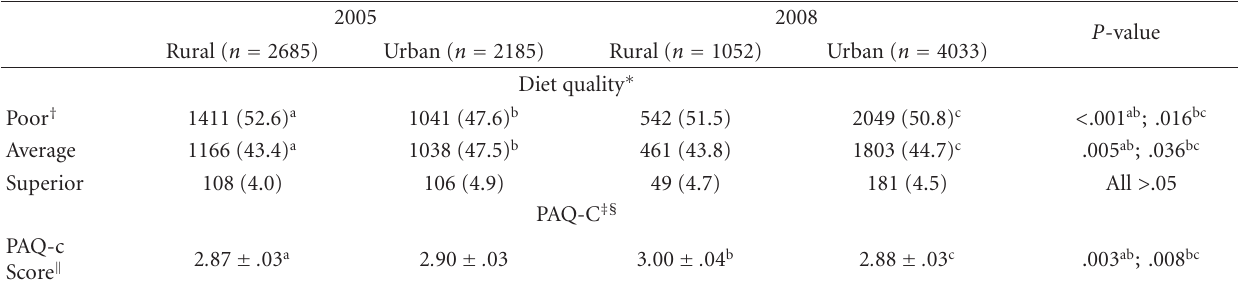
Table 2: The diet quality and physical activity levels of rural and urban students in 2005 and 2008.